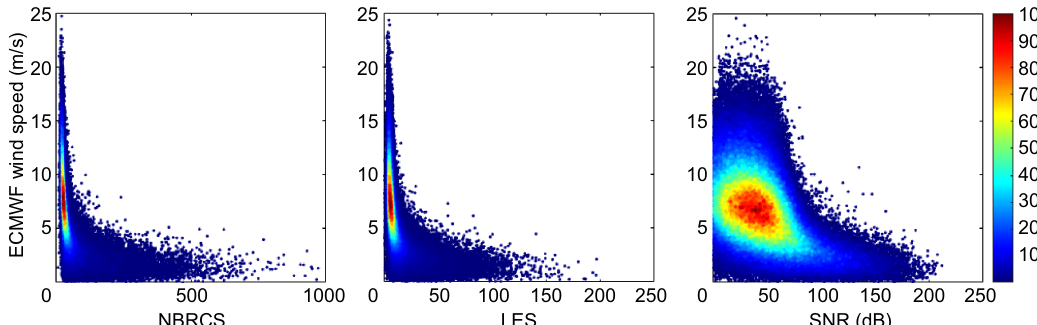
Fig. 1 The density map of the CYGNSS observables and ECMWF wind